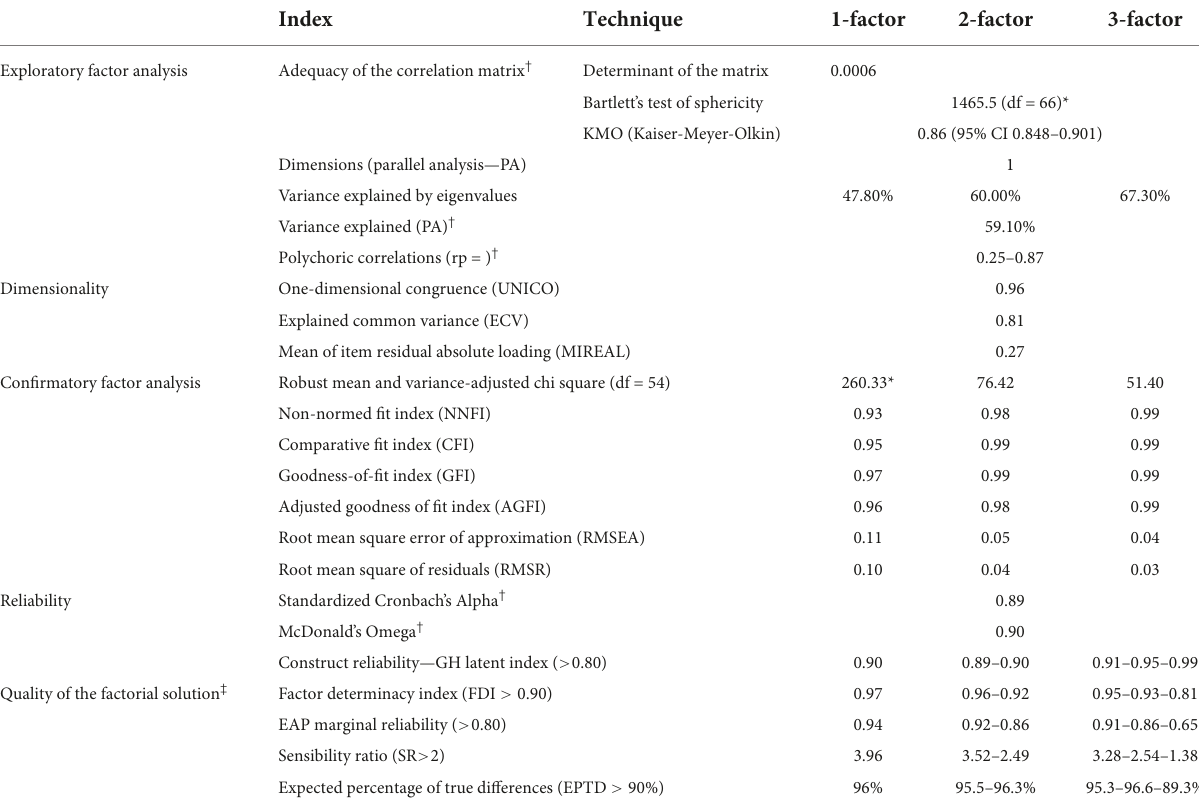
TABLE 3 Comparison of models of the FACIT-Sp-12 for one-, two-, and three-factor structures.